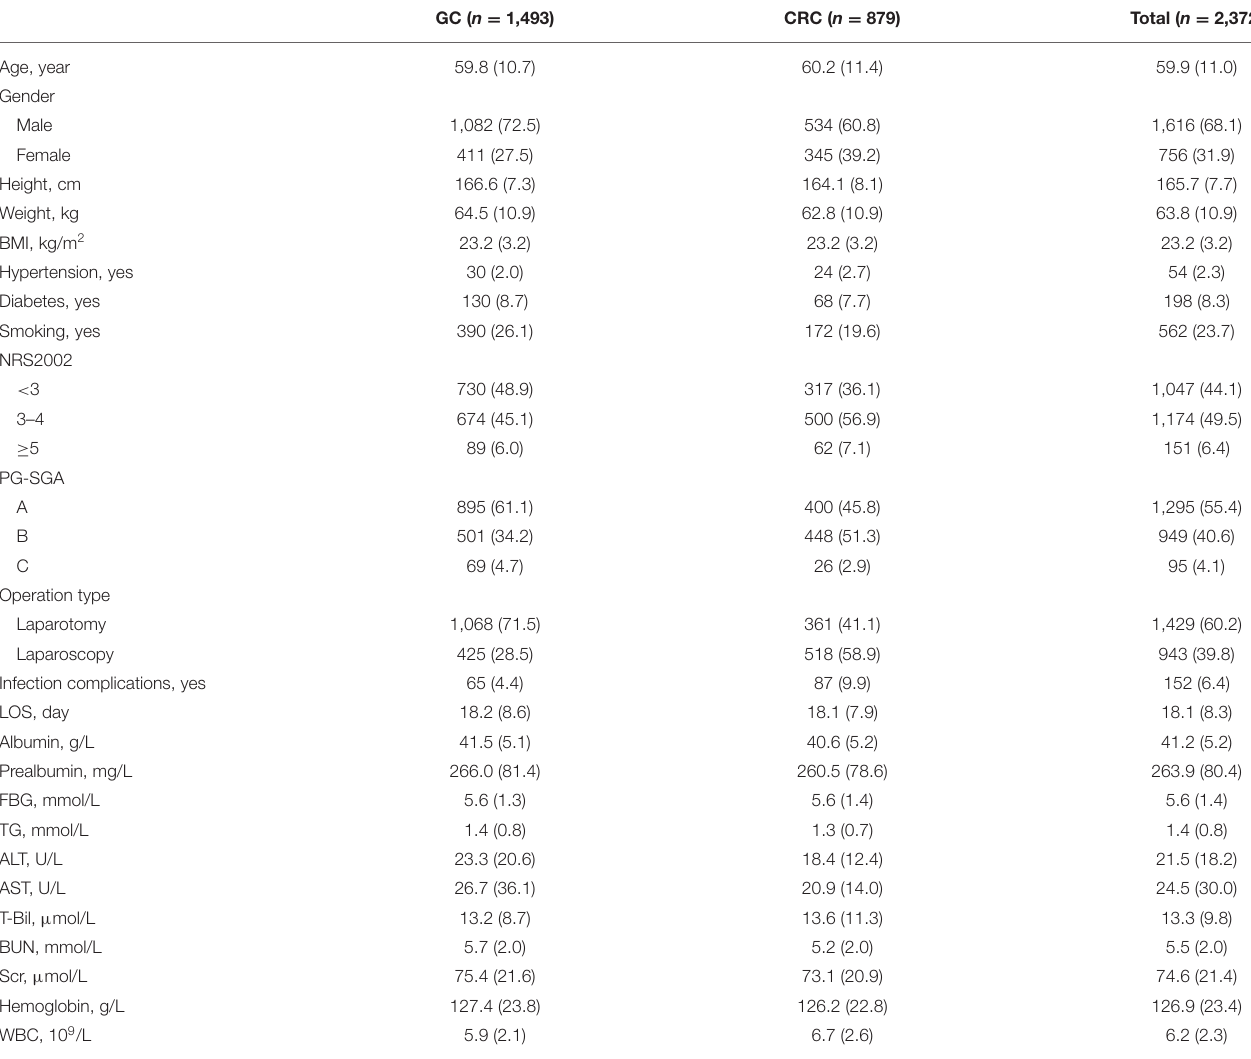
TABLE 1 | Characteristics of all